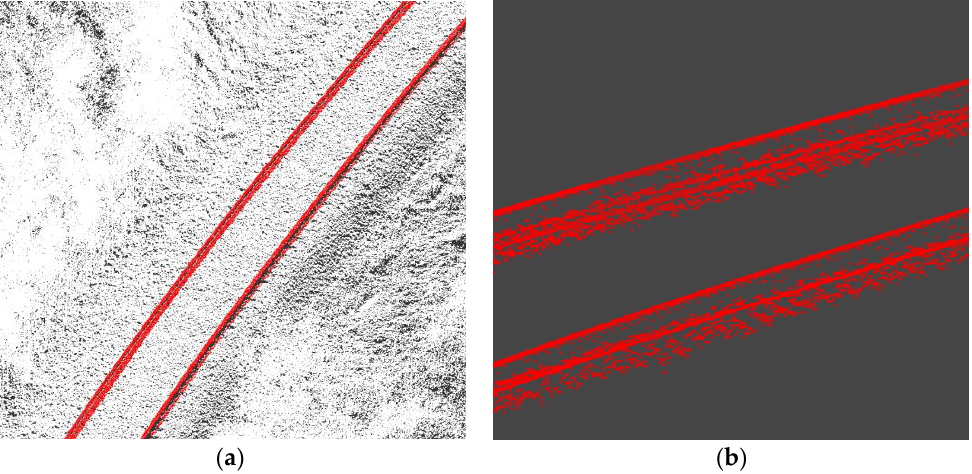
Figure 8. Rail track point cloud classification: ( a ) Scan angle classified cloud points, rail track points ( red ) and remaining points ( white ); ( b ) Rail track points detail.